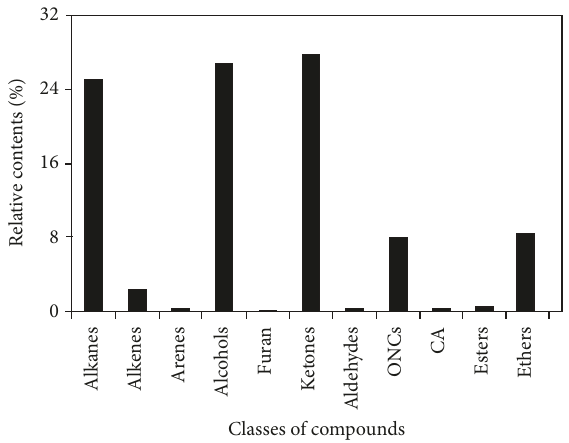
Figure 5: Relative contents of classes of compounds identified in EF PE .